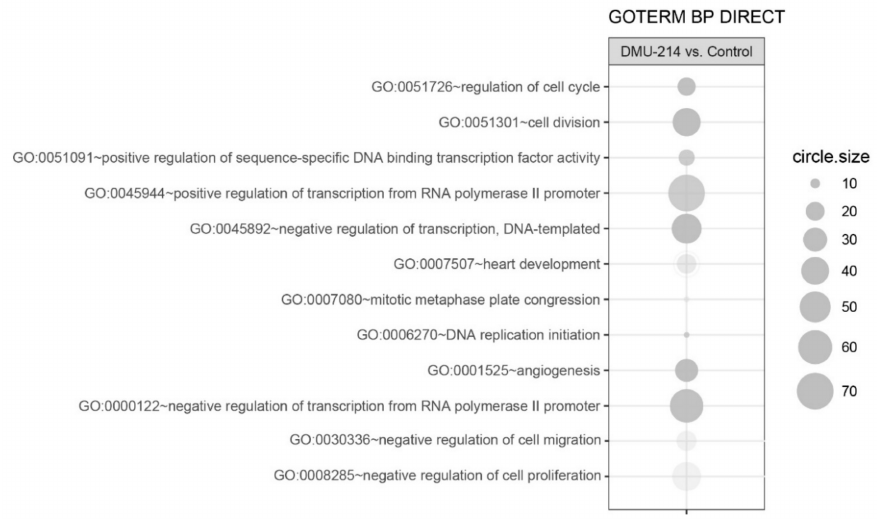
Figure 4. Bubble plot of overrepresented gene sets from DAVID GO BP DIRECT database. The graphs show only the GO groups above the established cut-o ff criteria ( p with correction < 0.05, a minimal number of genes per group > 5). The size of each bubble reflects the number of di ff erentially expressed genes assigned to the GO terms. The transparency of the bubbles displays the p -values (more transparent is closer to the border of p =